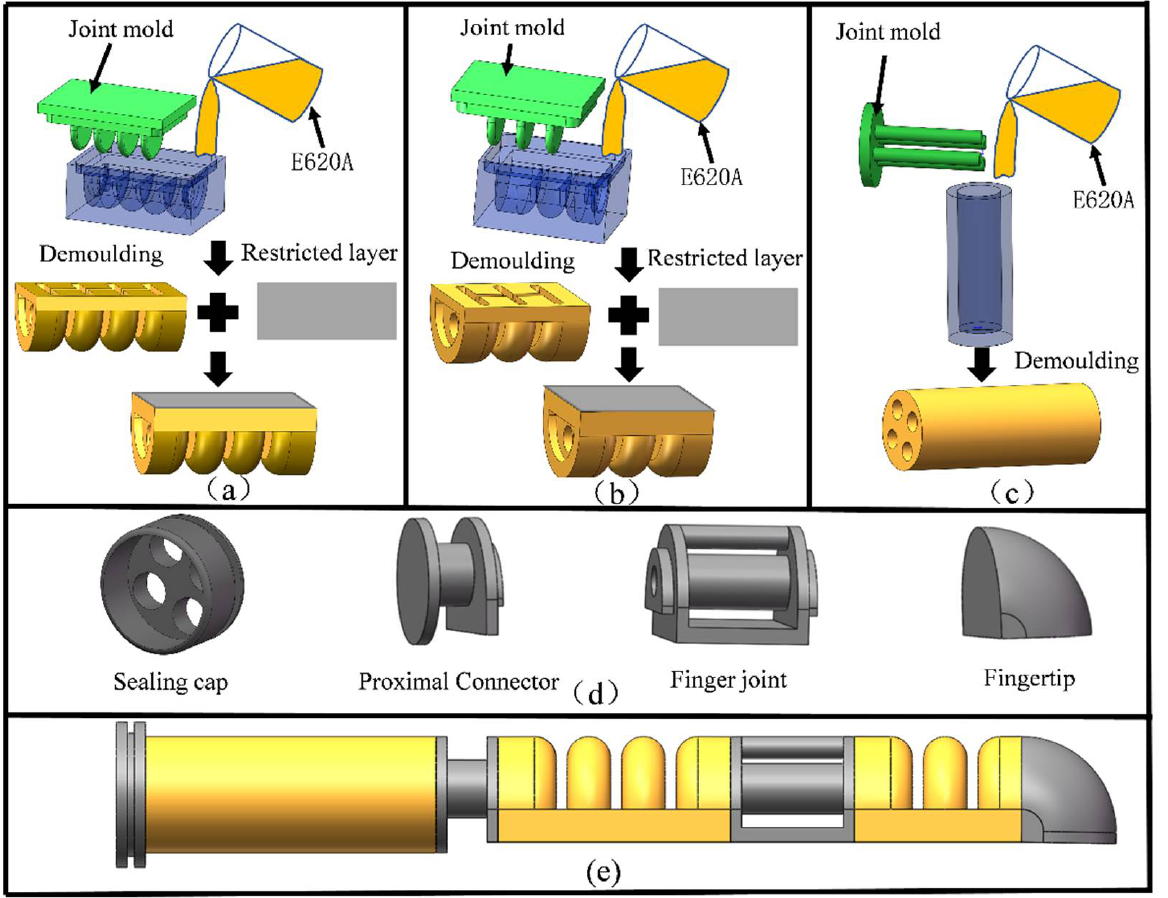
Figure 3. Software bionic finger preparation process: ( a ) the production process of the middle phalanx joint; ( b ) the production process of the distal phalanx joint; ( c ) the production process of the proximal phalanx joint; ( d ) the connecting frame; ( e ) the figure assembly.